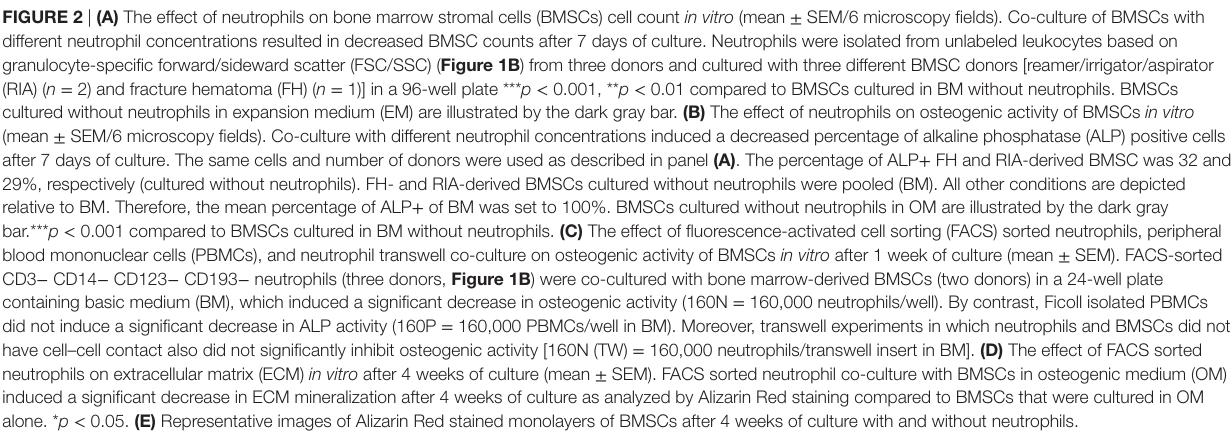
FigUre 2 | (a) The effect of neutrophils on bone marrow stromal cells (BMSCs) cell count in vitro (mean ± SEM/6 microscopy fields). Co-culture of BMSCs with different neutrophil concentrations resulted in decreased BMSC counts after 7 days of culture. Neutrophils were isolated from unlabeled leukocytes based on granulocyte-specific forward/sideward scatter (FSC/SSC) ( Figure 1B ) from three donors and cultured with three different BMSC donors [reamer/irrigator/aspirator (RIA) ( n = 2) and fracture hematoma (FH) ( n = 1)] in a 96-well plate *** p < 0.001, ** p < 0.01 compared to BMSCs cultured in BM without neutrophils. BMSCs cultured without neutrophils in expansion medium (EM) are illustrated by the dark gray bar. (B) The effect of neutrophils on osteogenic activity of BMSCs in vitro (mean ± SEM/6 microscopy fields). Co-culture with different neutrophil concentrations induced a decreased percentage of alkaline phosphatase (ALP) positive cells after 7 days of culture. The same cells and number of donors were used as described in panel (a) . The percentage of ALP + FH and RIA-derived BMSC was 32 and 29%, respectively (cultured without neutrophils). FH- and RIA-derived BMSCs cultured without neutrophils were pooled (BM). All other conditions are depicted relative to BM. Therefore, the mean percentage of ALP + of BM was set to 100%. BMSCs cultured without neutrophils in OM are illustrated by the dark gray bar.*** p < 0.001 compared to BMSCs cultured in BM without neutrophils. (c) The effect of fluorescence-activated cell sorting (FACS) sorted neutrophils, peripheral blood mononuclear cells (PBMCs), and neutrophil transwell co-culture on osteogenic activity of BMSCs in vitro after 1 week of culture (mean ± SEM). FACS-sorted CD3 − CD14 − CD123 − CD193 − neutrophils (three donors, Figure 1B ) were co-cultured with bone marrow-derived BMSCs (two donors) in a 24-well plate containing basic medium (BM), which induced a significant decrease in osteogenic activity (160N = 160,000 neutrophils/well). By contrast, Ficoll isolated